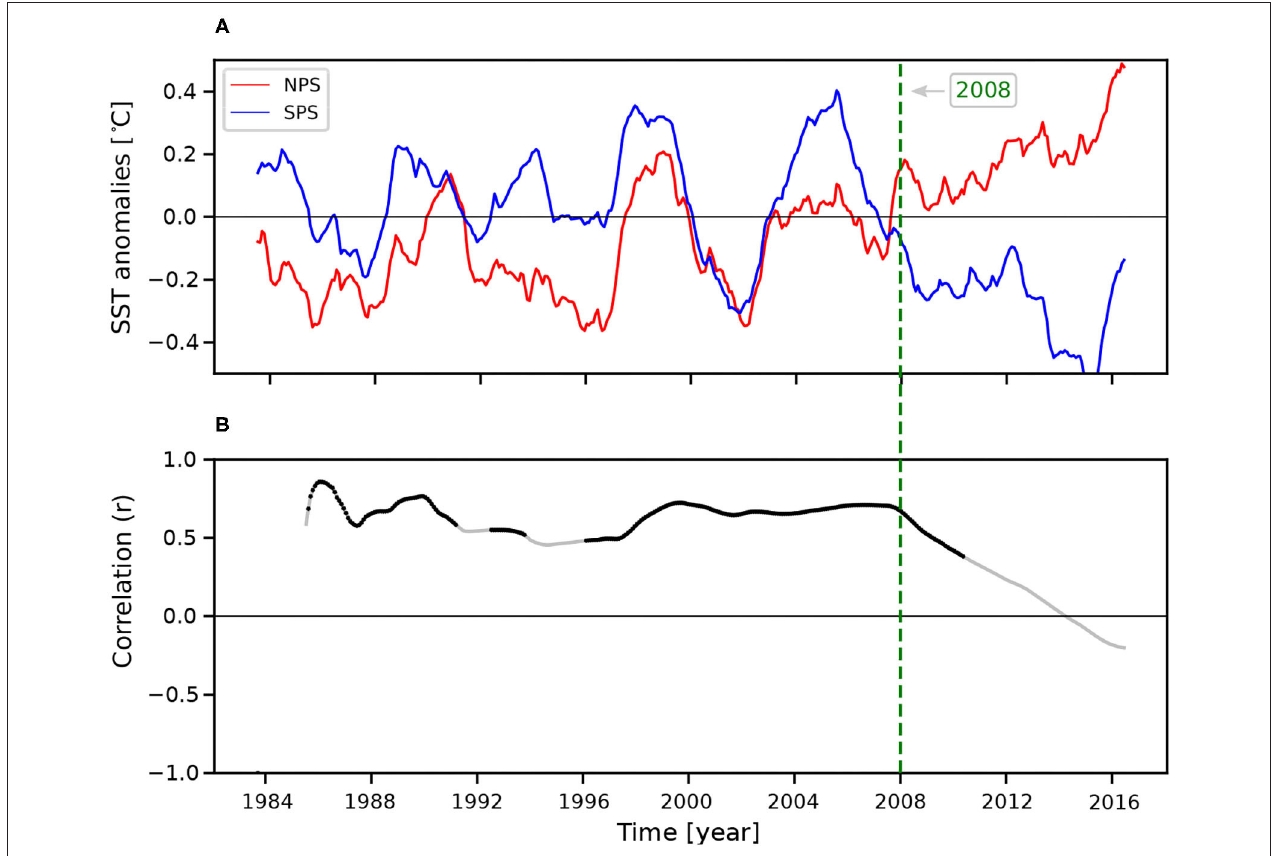
FIGURE 7 | (A) Time series of filtered SSTa at NPS (solid red line) and SPS (solid blue line). The time series are identical to those shown in Figures 5A,C . (B) Temporal evolution of the correlation coefficient (r) between SSTa at NPS and SPS. Heavy black lines indicate significant correlations at the 95% confidence level. The dashed green line indicates the “breakpoint” year centered at 2008 as identified in Section 3.2.2.